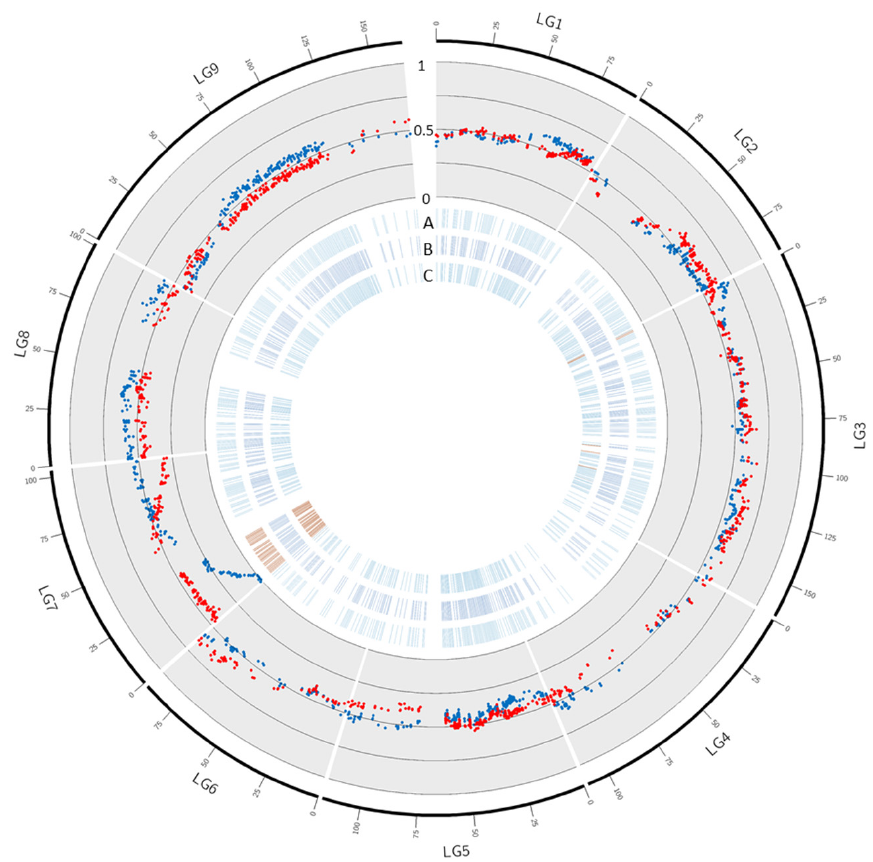
Figure 4. Segregation distortion in ‘Ellendale’. Blue and red dots in the scatter plot represent respectively male and female gamete frequency in ‘Ellendale’ haplotype 1. A, B, and C: blue and red dashes represent markers with non-significant and significant distortion in ( A ): male gametes, ( B ): female gametes and ( C ): all gametes.